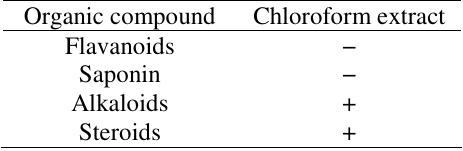
Table 3. Organic constituents of Datura metel